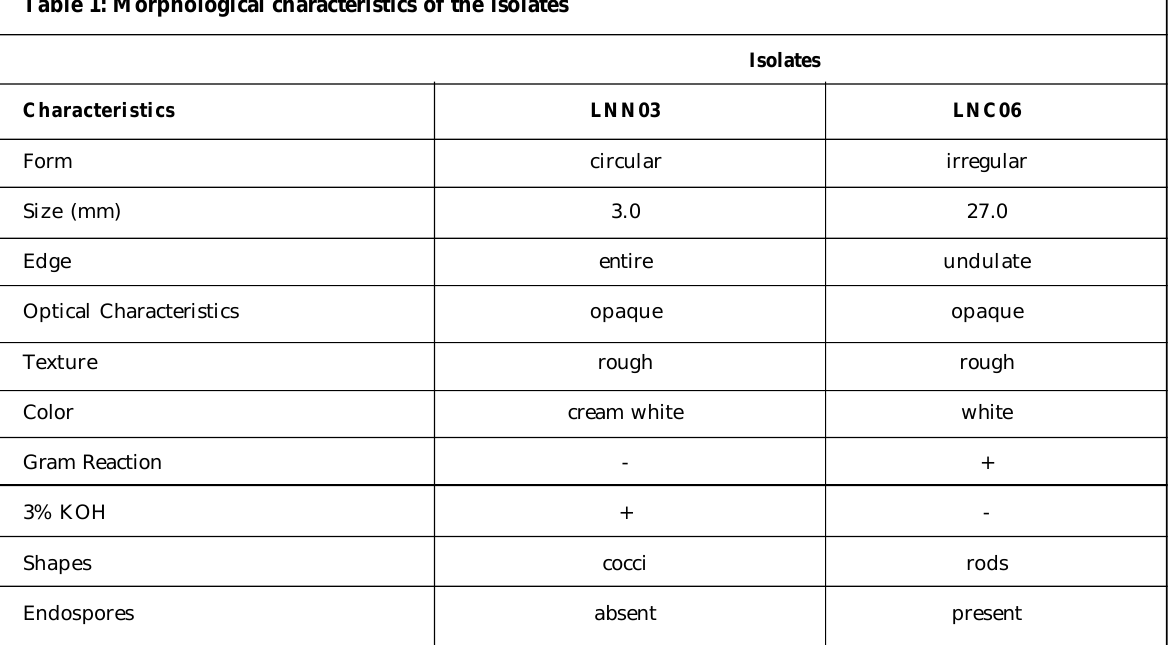
Table 1: Morphological characteristics of the